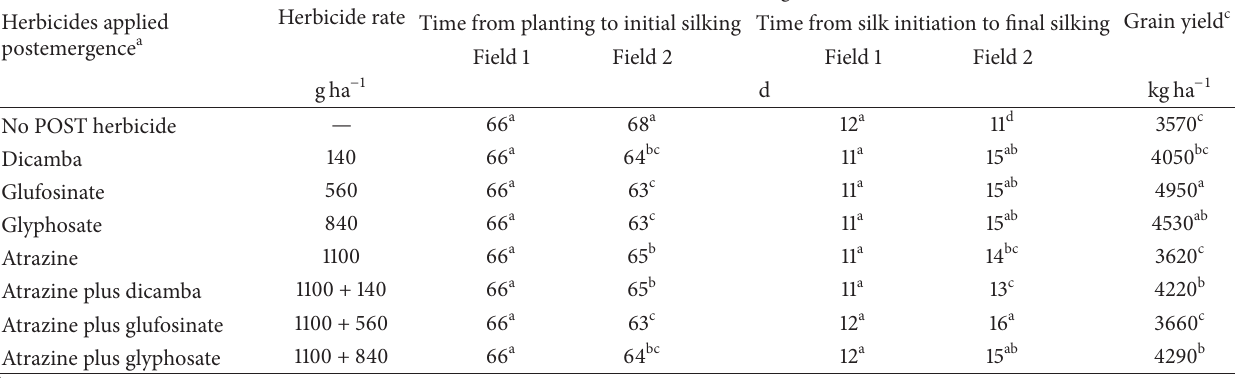
Table 3: Days from planting to initial silk emergence and silking duration as influenced by herbicide program during 2012 at Lewiston- Woodville.